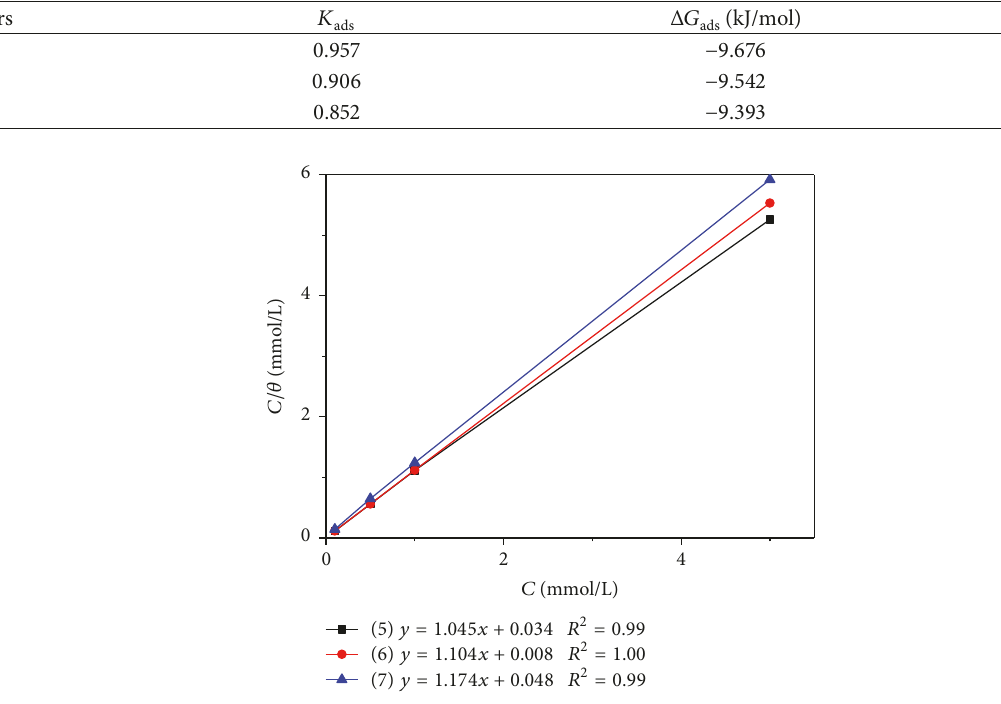
Figure 5: Langmuir adsorption plot for steel in 1MHCl containing different inhibitors at 293